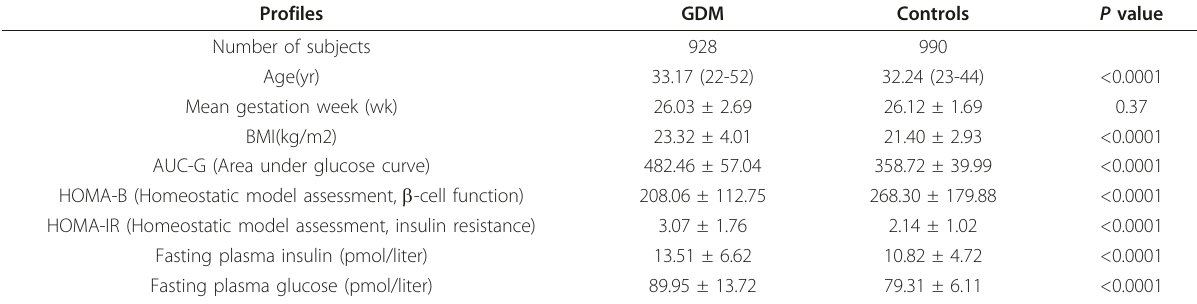
Table 1 Clinical profiles of subjects Profiles